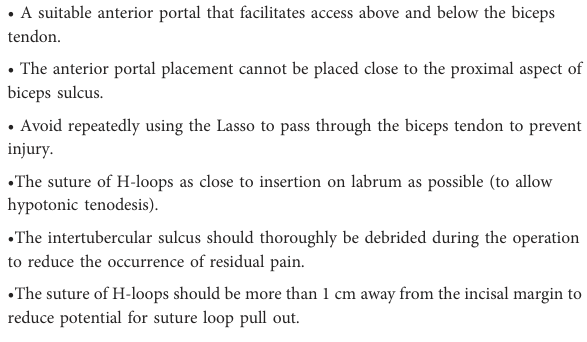
TABLE 1 Technical pearls and pitfalls of H-loop tenodesis of LHB.